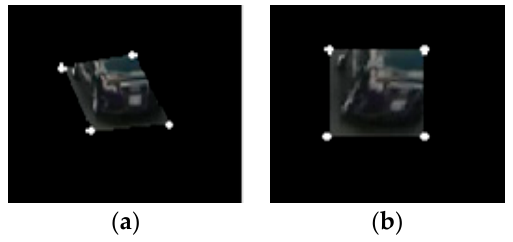
Figure 4. The image of the parking space: ( a ) before the adjustment; ( b ) after the perspective